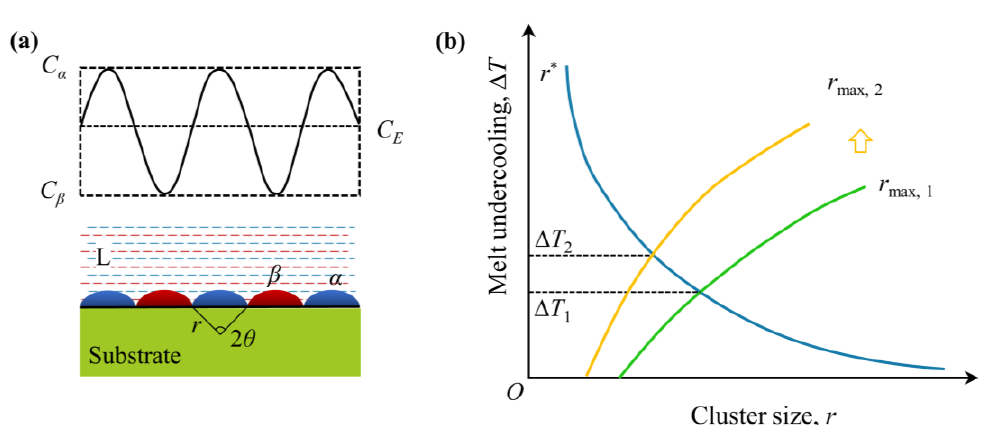
Figure 7. Constituent fluctuation ( a ) and relationships among heterogeneous nucleation undercooling, ∆ T ; critical nucleation size, ( r* ); and ( b ) maximum crystal embryos ( r max ), where the upward arrow indicates an increase in critical size [102]. Copyright © 2022 Elsevier Ltd.